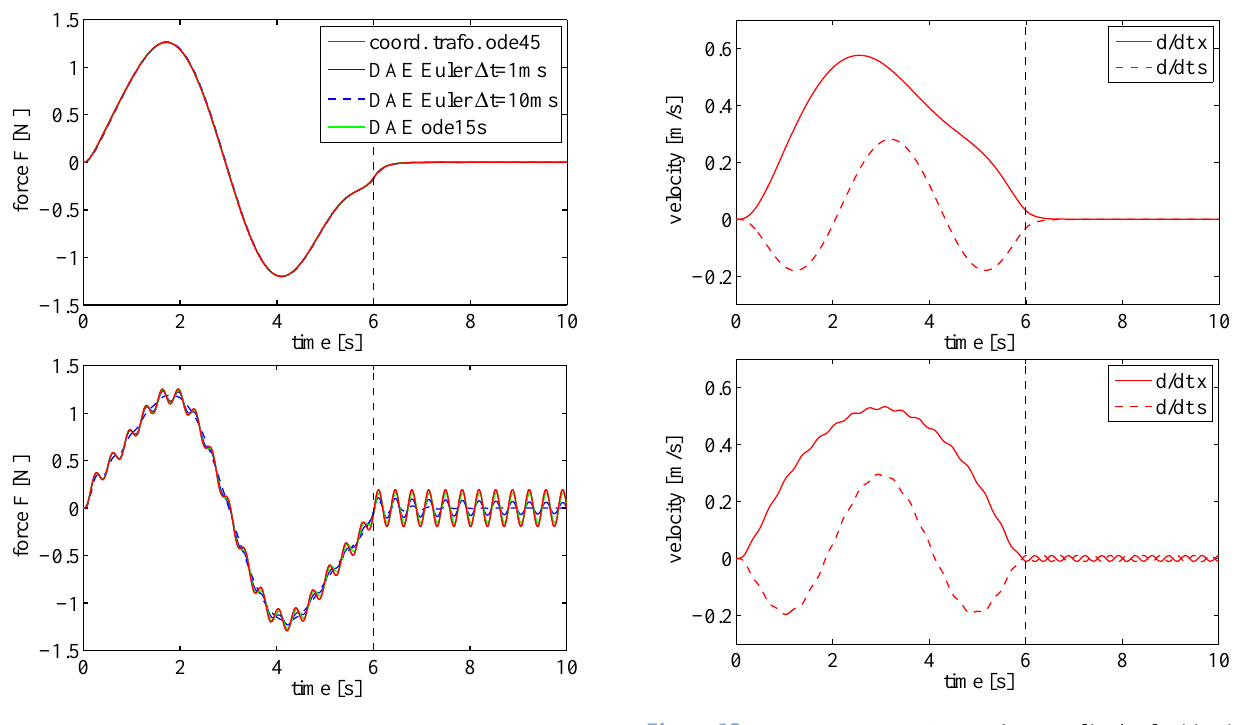
Figure 12. Mass on car – case 2, α = 5 ◦ : computed control input u d . With damping d = 1Nsm − 1 (top) and without damping (bottom).